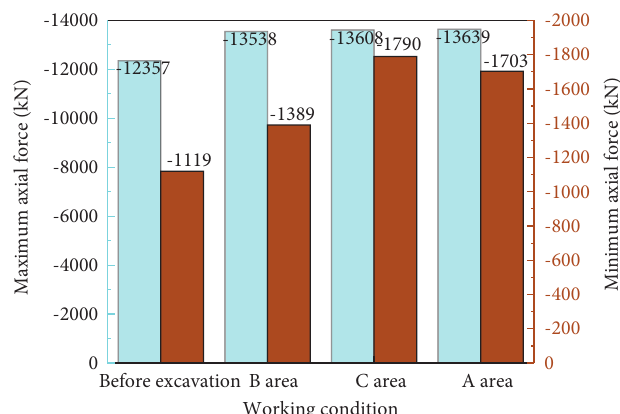
Figure 13: Maximum axial force of the station column during foundation pit excavation.